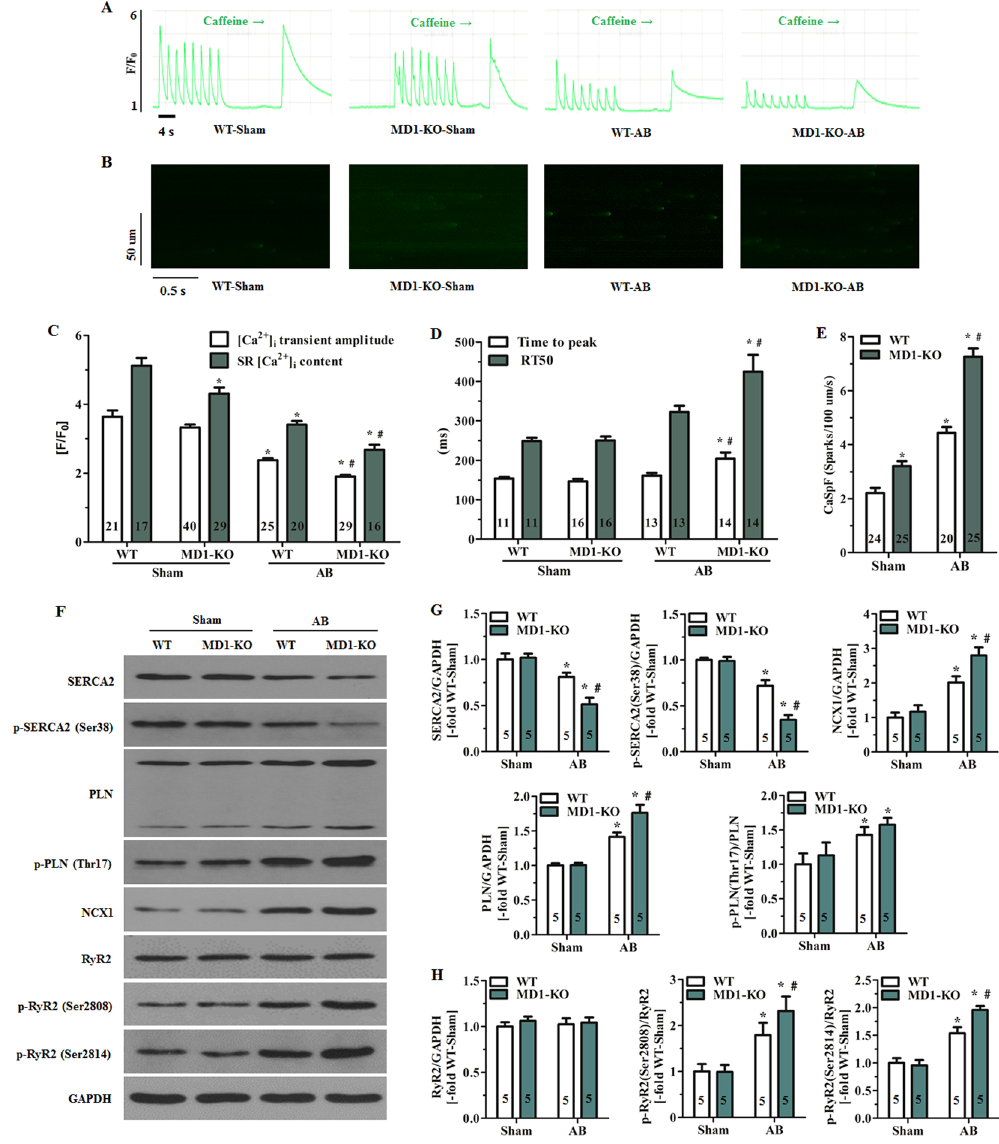
Figure 5. MD1 modulates intracellular Ca 2 + handling in response to pressure overload. ( A ) Representative recordings (F/F 0 ) of steady-state Ca 2 + transients followed by rapid caffeine administration and ( B ) confocal line-scan images of mouse LV myocytes. Cells were isolated from WT and MD1-KO mice at 4 weeks after surgery. ( C ) Statistical analysis of systolic Ca 2 + transient amplitude and SR Ca 2 + content in the indicated groups (5–6 mice/group). ( D ) Time to peak [Ca 2 + ] i transient amplitude and duration of [Ca 2 + ] i transient decay (4–5 mice/group). RT50 = half-maximal relaxation time. ( E ) Quantification of CaSpF in the indicated groups (3–4 mice/group). ( F ) Original immunoblots of major Ca 2 + handling proteins (including total and phosphorylated proteins). Statistical analysis of WT and MD1-KO heart samples at 4 weeks after surgery for ( G ) expression of total SERCA2, total PLN, and NCX1, phosphorylation of SERCA2 at Ser38, and PLN phosphorylation at Thr17 normalised to total PLN; ( H ) total RyR2 expression, and RyR2 phosphorylation at Ser2808 and Ser2814 normalised to total RyR2. Data were normalised to GAPDH. Numbers within columns indicate the number of LV myocytes ( C – E ) and heart samples ( G , H ). * P < 0.03 vs. WT-Sham, # P < 0.05 vs.